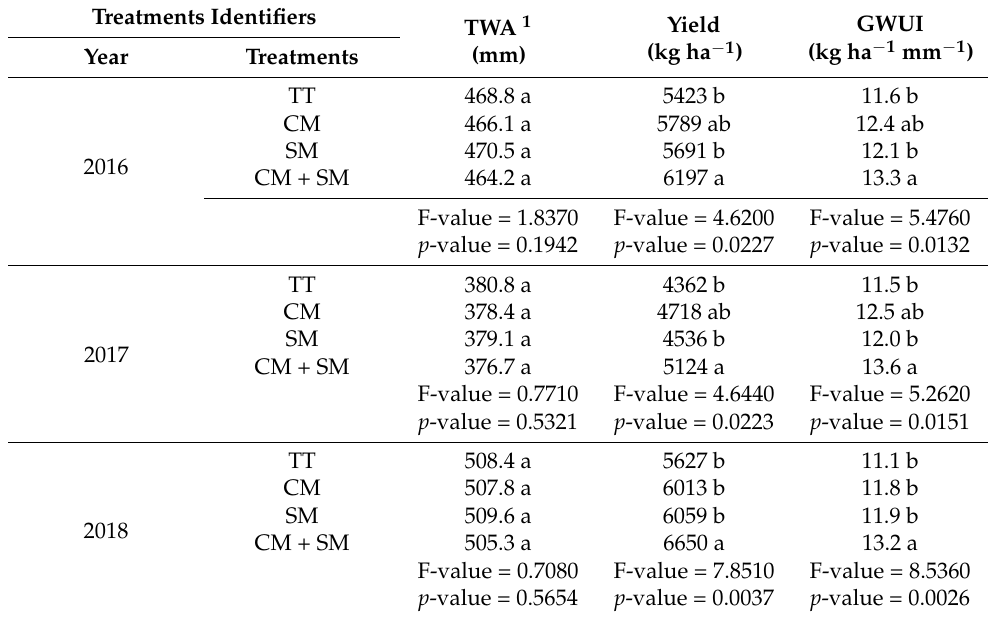
Table 5. Yield and water use efficiency of summer maize for traditional tillage (TT), cattle manure mixing (CM), maize straw mulching (SM), and combined manure mixing and straw mulching (CM + SM) treatments during the experimental years. Means within a column in the same year followed by the same letters are not statistically different according to least significant difference test ( p =